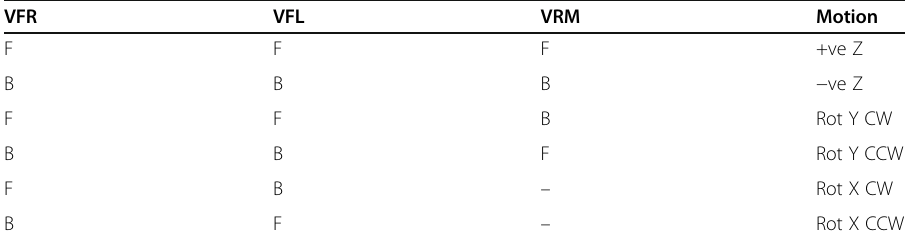
Table 2 Vertical thrusters ’ operation